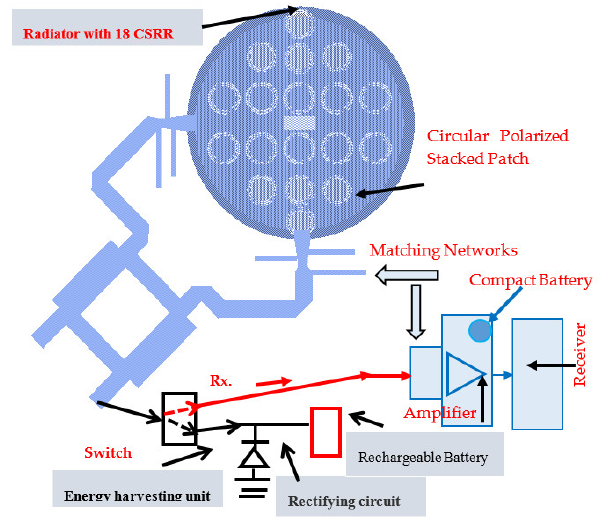
Figure 8. Block diagram of a receiver with wearable active circular polarized antenna.